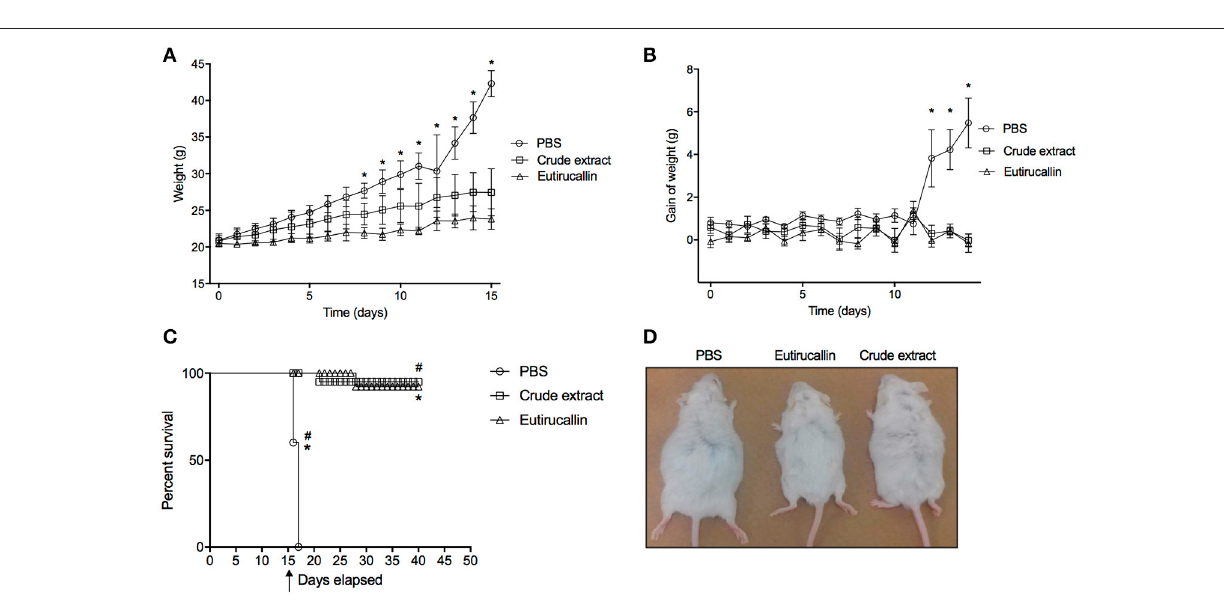
FIGURE 6 | Evaluation of survival and weight curve of EAC bearing mice treated daily through intraperitoneal route with 50 ug of Crude extract or Eutirucallin. (A) Total body weight change of EAT tumor bearing mice treated daily with PBS, Crude extract and Eutirucallin. (B) Gain weight of EAT tumor bearing mice treated daily with PBS, Crude extract and Eutirucallin. (C) Represents the percentage of survival indicating that all mice treated with PBS died. *Represents statistically difference ( P < 0.05) comparing PBS with Crude extract and Eutirucallin. (D) Representative photo of mice treated with PBS, Eutirucallin and Crude extract. *Represents statistically difference ( P < 0.05) comparing PBS with Eutirucallin. # Represents statistically difference ( P < 0.05) comparing PBS with Crude extract. Arrow represents the day of the terminal of the